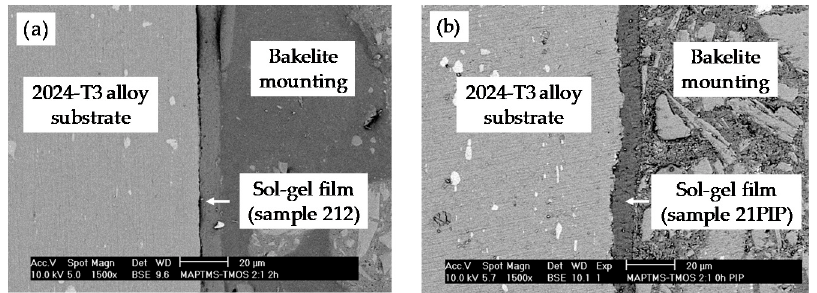
Figure 6. Cross-section SEM images of sol–gel films applied on AA2024-T3 aluminum alloy: ( a ) 212 sample and ( b ) 21PIP sample (scale bar: 20 μ m).